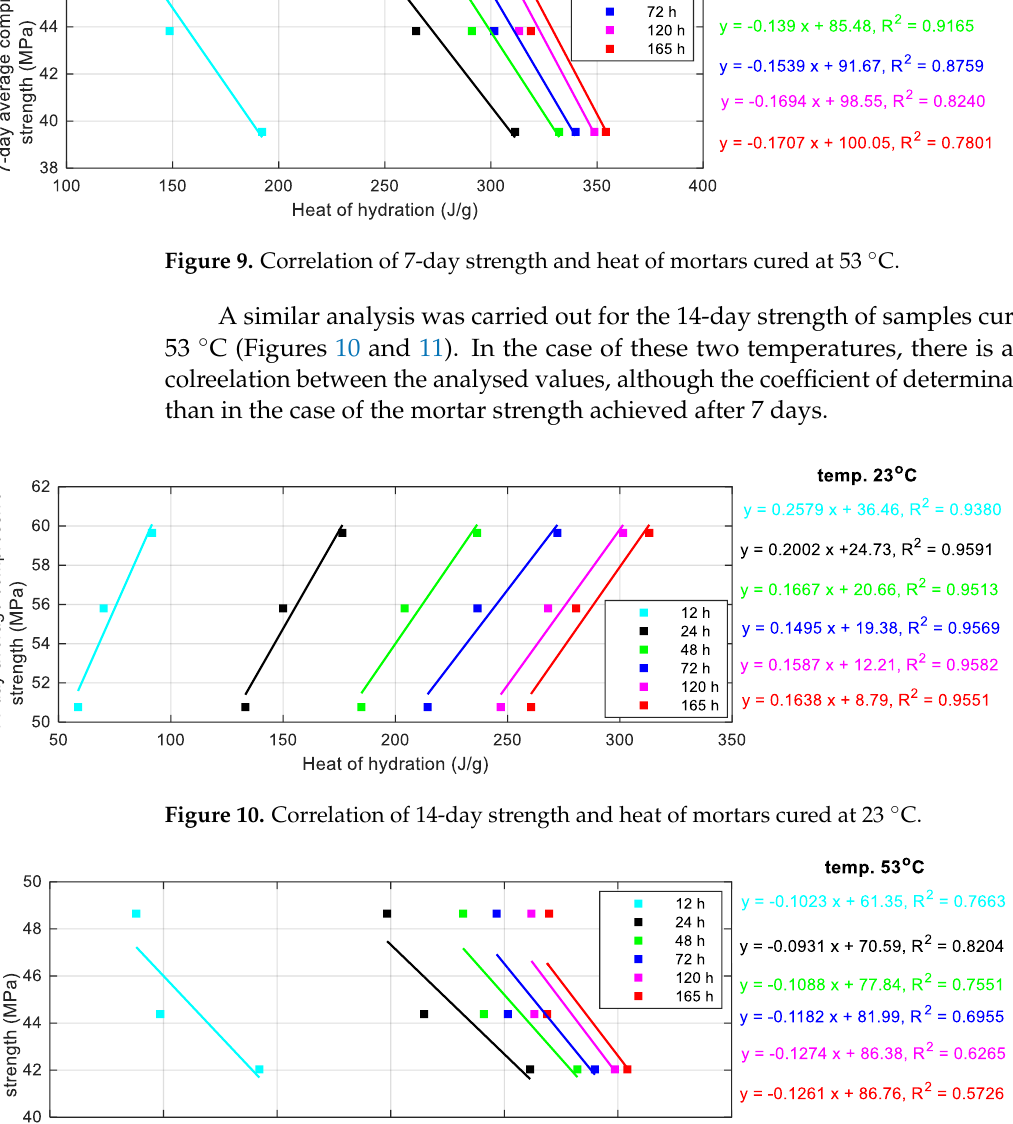
Figure 8. Correlation of 7-day strength and heat of mortars cured at 43 °C.